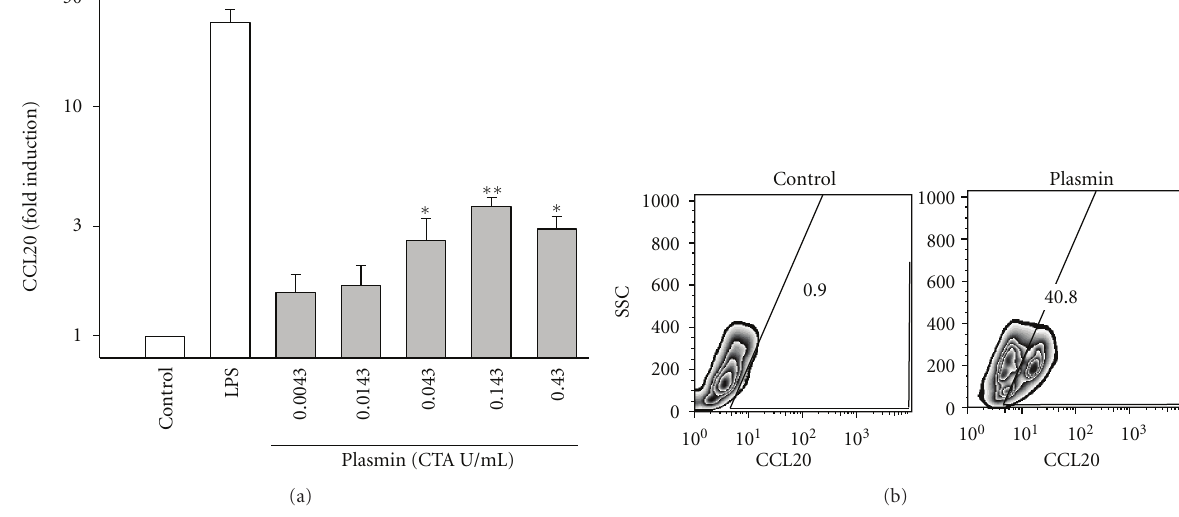
Figure 3: Plasmin elicits CCL20 protein expression in dendritic cells. (a) Plasmin induces a concentration-dependent release of CCL20. Dendritic cells were stimulated with various concentrations of plasmin or LPS (0.5 μ g/mL) for 24 h before being analyzed by ELISA. The results are mean ± SEM of 8 experiments, ∗ P < 0.05, ∗∗ P < 0.01 versus control. (b) Flow cytometric analysis of CCL20 expression by dendritic cells. Dendritic cells were either unstimulated or stimulated with plasmin (0.143CTAU/mL) for 24 h. Brefeldin A was added to the cell culture 4h before the end of the incubation, and the cells were fixed, permeabilized, stained, and analyzed by flow cytometry. Representative data of 3 independent experiments are shown.